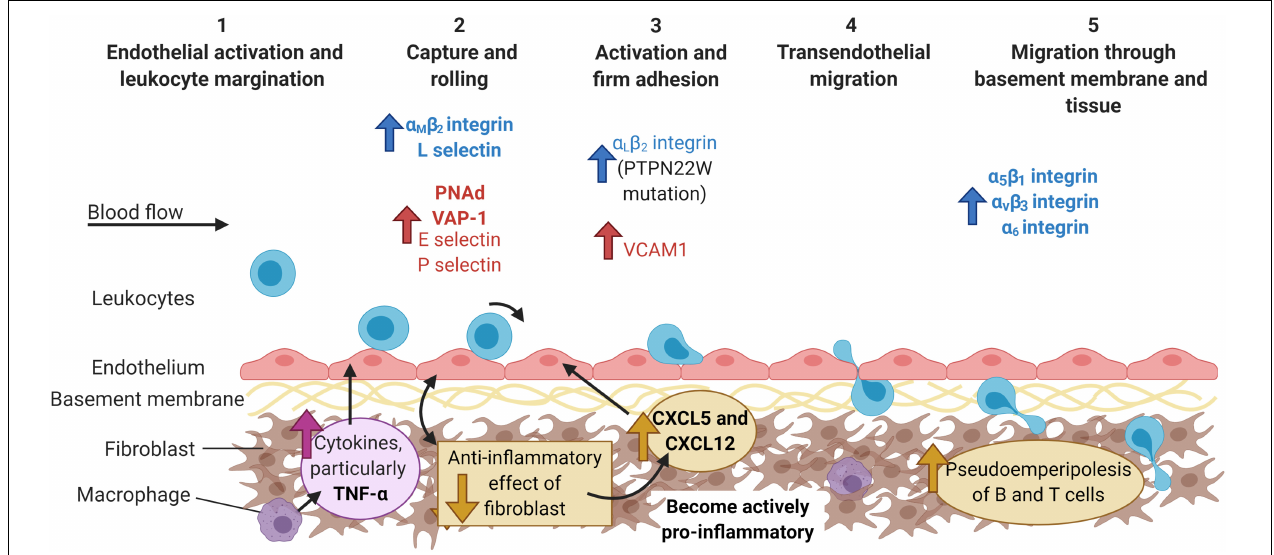
FIGURE 3 | The multi-step adhesion cascade in chronically inflamed joints. The etiology of most inflammatory arthritides remains unknown. At some point during the initial phases of disease, the endothelial cells up-regulate the expression of the typical adhesion molecules (E and P selectin, VCAM), as well as other molecules usually found in HEV venules (PNAd) or the gut (VAP-1). Furthermore, fibroblasts switch from homeostatically anti-inflammatory, to actively pro-inflammatory with the production of chemokines (CXCL5 and CXCL12) that are shuttled to the endothelium. Leukocytes from arthritic patients exhibit higher expression of integrins, such as α L β 2 -, α M β 2 -, and α 6 -, and are recruited to the endothelium via P-selectin (neutrophils) and α 4 β 1 -integrin-VCAM-1 interactions (lymphocytes). Increased expression of α 5 β 1, α v β 3, and α 6 integrins on leukocytes aids their migration through the basement membrane and tissue, whilst fibroblast interactions with T and B cells increases pseudoemperipolesis. Molecules are colored according to cell type: leukocytes = blue and endothelial cells = red, and highlighted bold to denote major contributors to infiltration during inflammatory arthritis, but not in response to infection or damage. PNAd, peripheral node addressin; VAP-1, vascular adhesion protein 1; VCAM-1, vascular adhesion protein 1. Created with